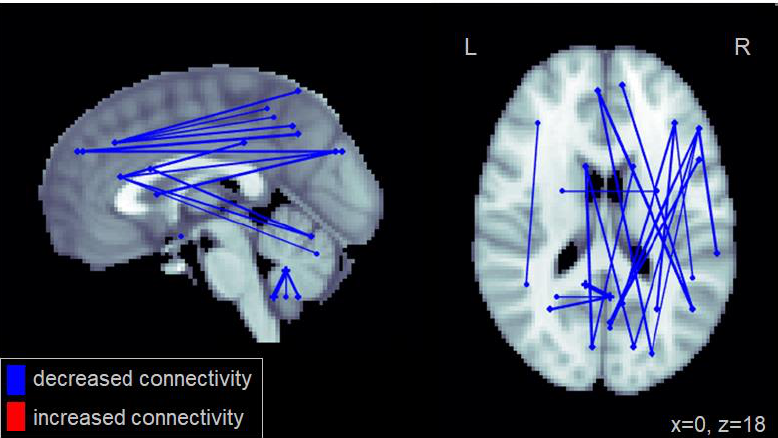
Figure 1. Altered functional connectivity observed for the MCI group compared to the healthy control group. Blue lines denote functional connections with reduced connectivity in MCI patients, red lines denote increased connectivity (significant at FDR = 0.05). Connections are shown as projections in the sagittal and axial plane, with MNI anatomical underlays (slices at x = 0 and z = 18 respectively).